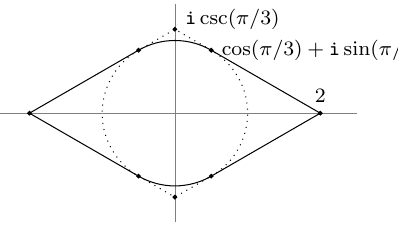
Fig. 1. Boundary of (cid:128) D conv .W.A 0 / [ W.A 1 //